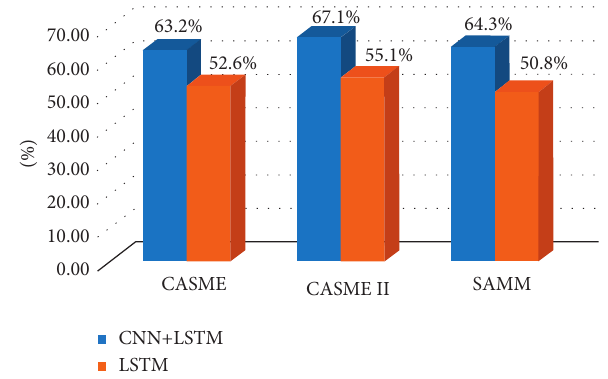
Figure 13: Recognition rates of different algorithm models under three